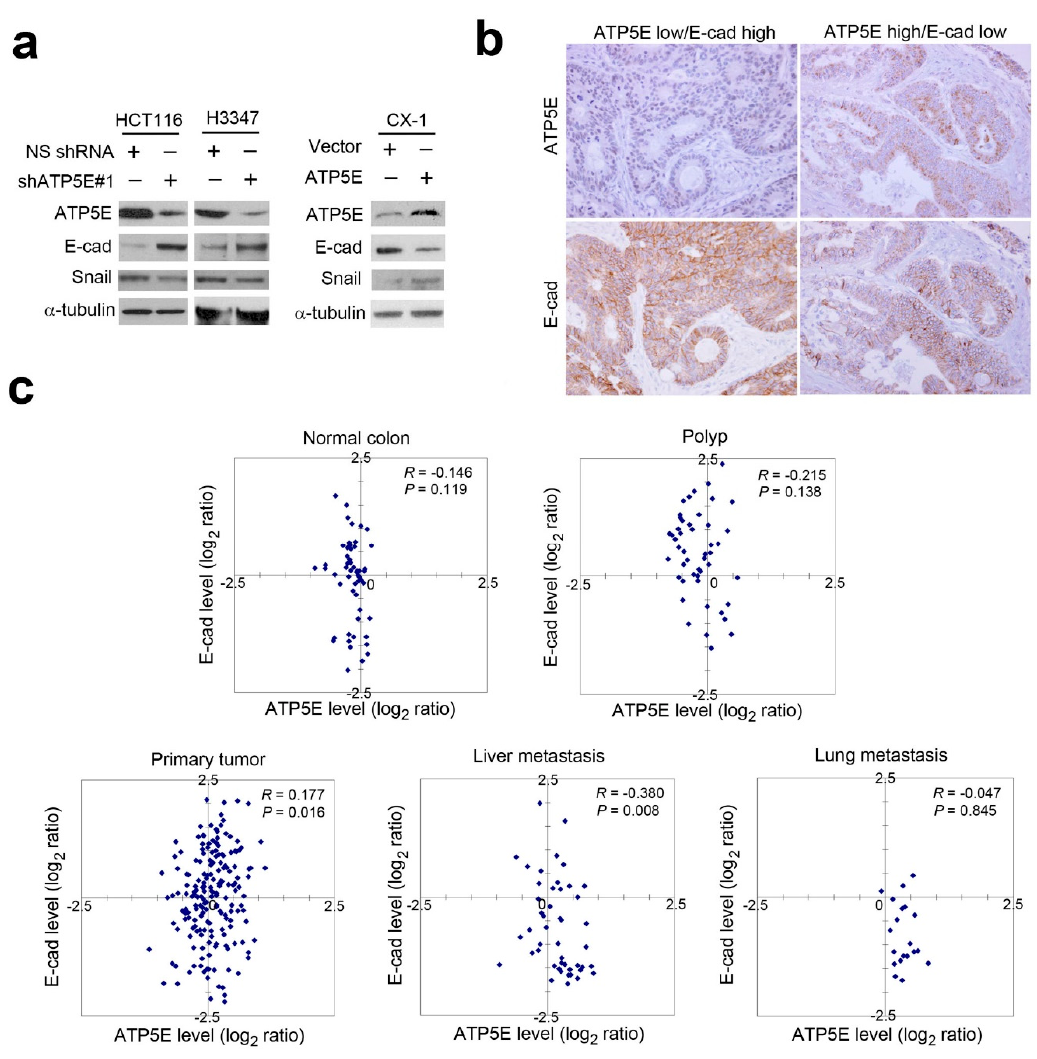
Figure 3. ATP synthase epsilon subunit (ATP5E) expression induces the epithelial-to-mesenchymal transition. ( a ) Western blot analysis of E-cadherin and Snail expressions upon ATP5E knockdown and overexpression. ( b ) IHC staining of ATP5E and E-cadherin in serial sections of colon cancer specimens. ( c ) ATP5E and E-cadherin expression profiles of normal colon, polyp, primary colon tumor, liver metastatic tumor, and lung metastatic tumor tissues in the GSE41258 microarray dataset.